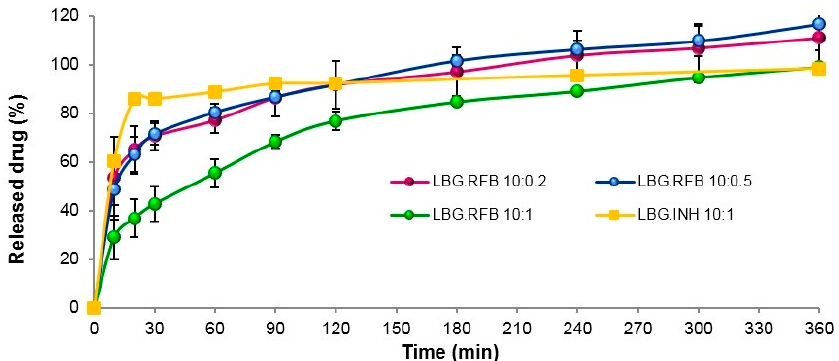
Figure 4. In vitro release of isoniazid (INH) from LBG:INH (10:1, w / w ) microparticles and of rifabutin (RFB) from LBG:RFB microparticles at mass ratios 10:0.2, 10:0.5 and 10:1, in PBS pH 7.4.Tween 80 ® (LBG: locust bean gum; mean ± SD, n = 3).